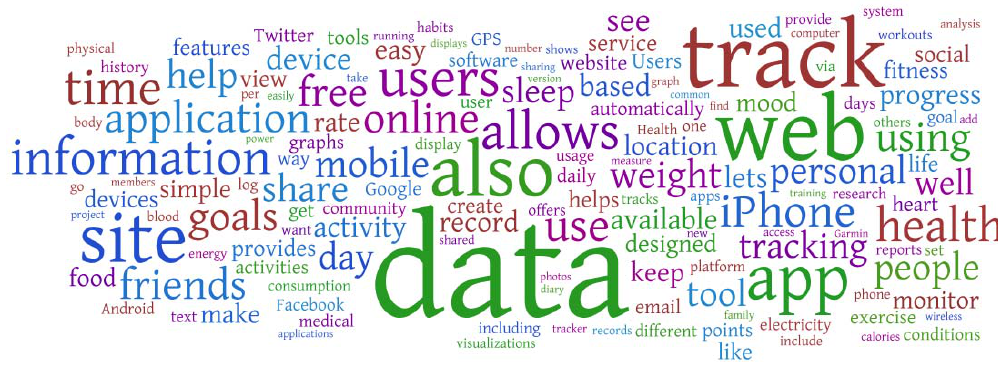
Figure 4. The Pebble watch (preorder: $150, http://getpebble.com/) has received a lot of attention